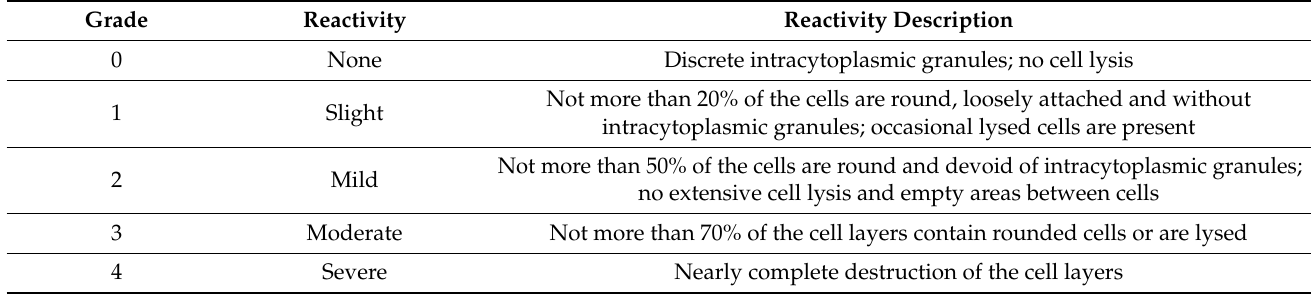
Table 1. Grades of cytotoxicity scored according to ISO 10993-5 2009 standard